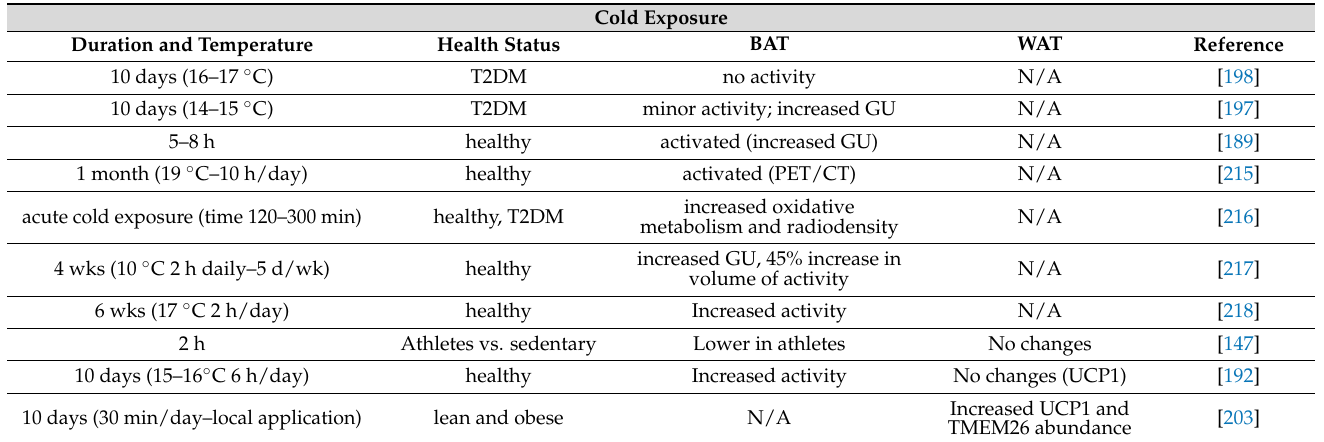
Table 2. Impacts of cold exposure, exercise interventions, dietary composition, and pharmacological compounds on BAT and WAT metabolism in